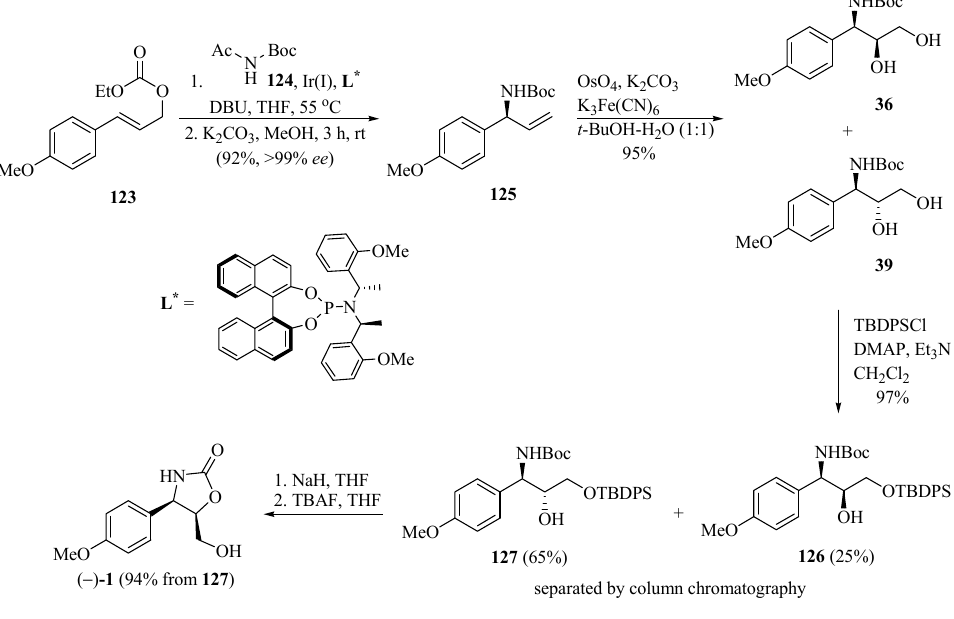
chromatography1. Scheme 22. Total synthesis of ( − )-cytoxazone reported by Han and Singh [37]. 2.20. An Advance on Exploring N-tert-Butanesulfinyl Imines in Asymmetric Synthesis of Chiral Amines